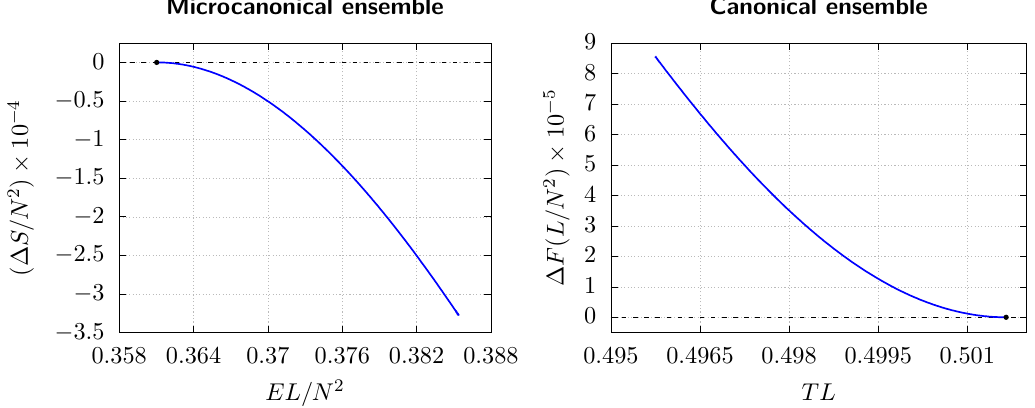
Figure 2. Phase diagram in the microcanonical ensemble (left) and the canonical ensemble (right), for ‘ = 1 lumpy black holes. The GL threshold point is indicated with a black solid disc. The zero is taken to be the Schwarzschild-AdS 5 black hole phase. Lumpy black holes are always 5 × S subdominant in both ensembles. The phase diagrams of the other families of lumpy black holes that we have constructed are qualitatively similar, except for the ‘ = 2 − family.